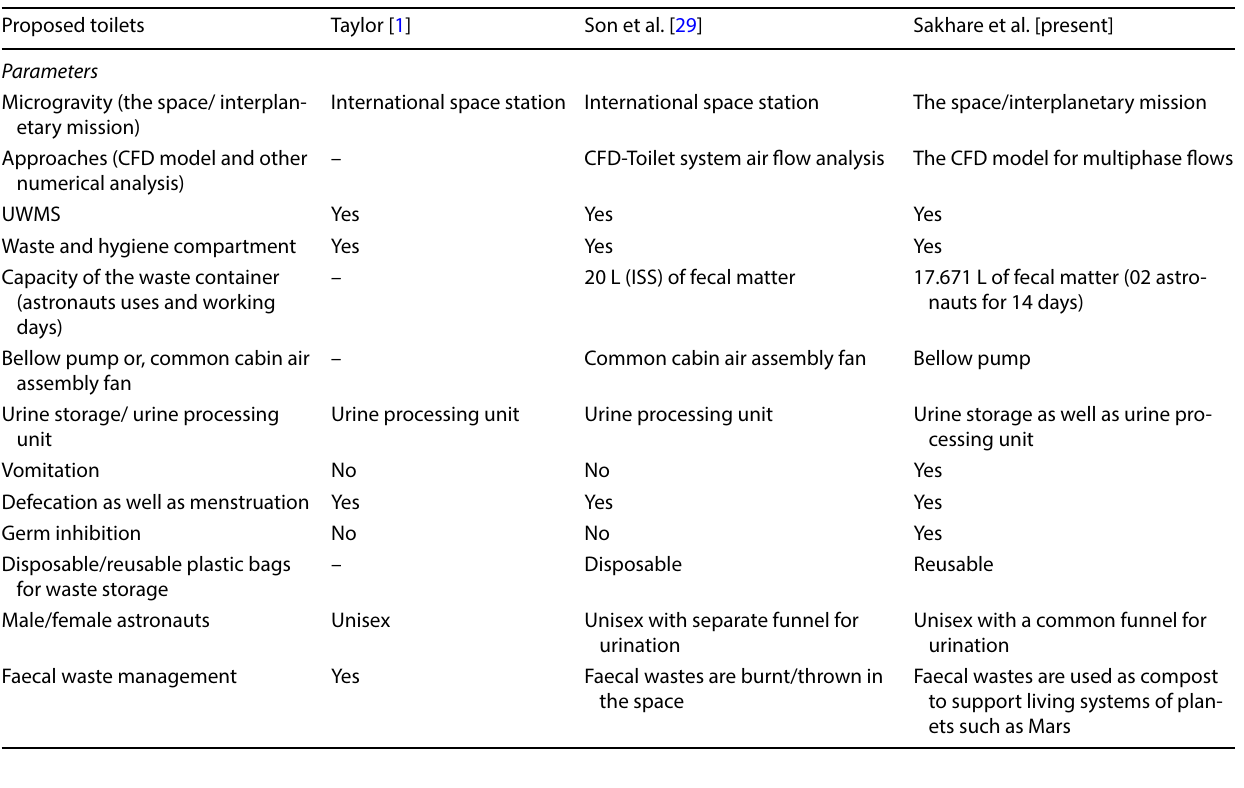
Table 2 A brief comparison with other available ISS toilets proposed so far Proposed